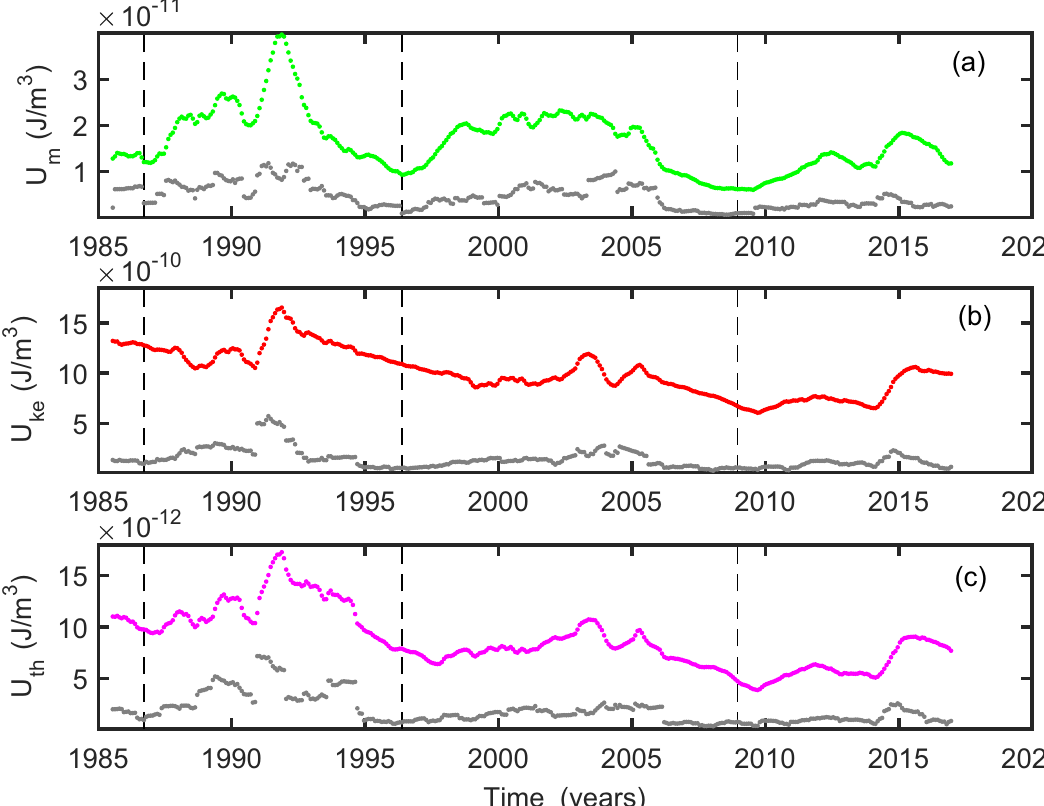
), (b) kinetic energy density 0